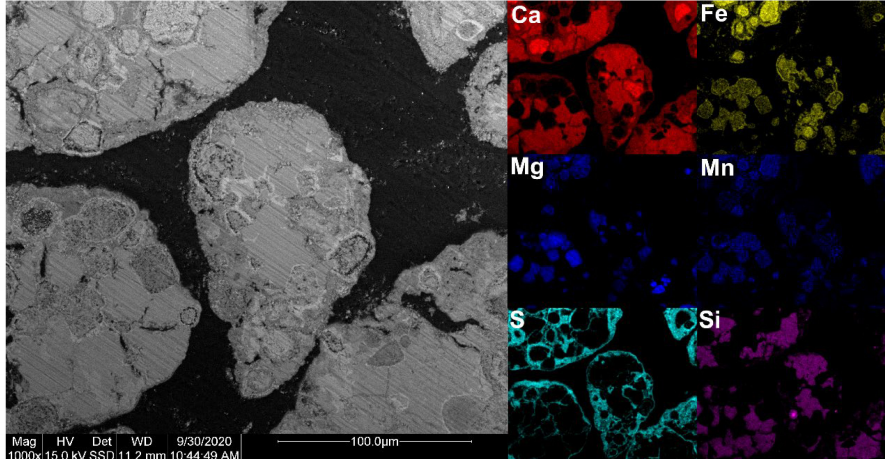
Figure 16. SEM-EDX image of LD slag that has been loaded with SO 2 and reduced once at 870 ◦